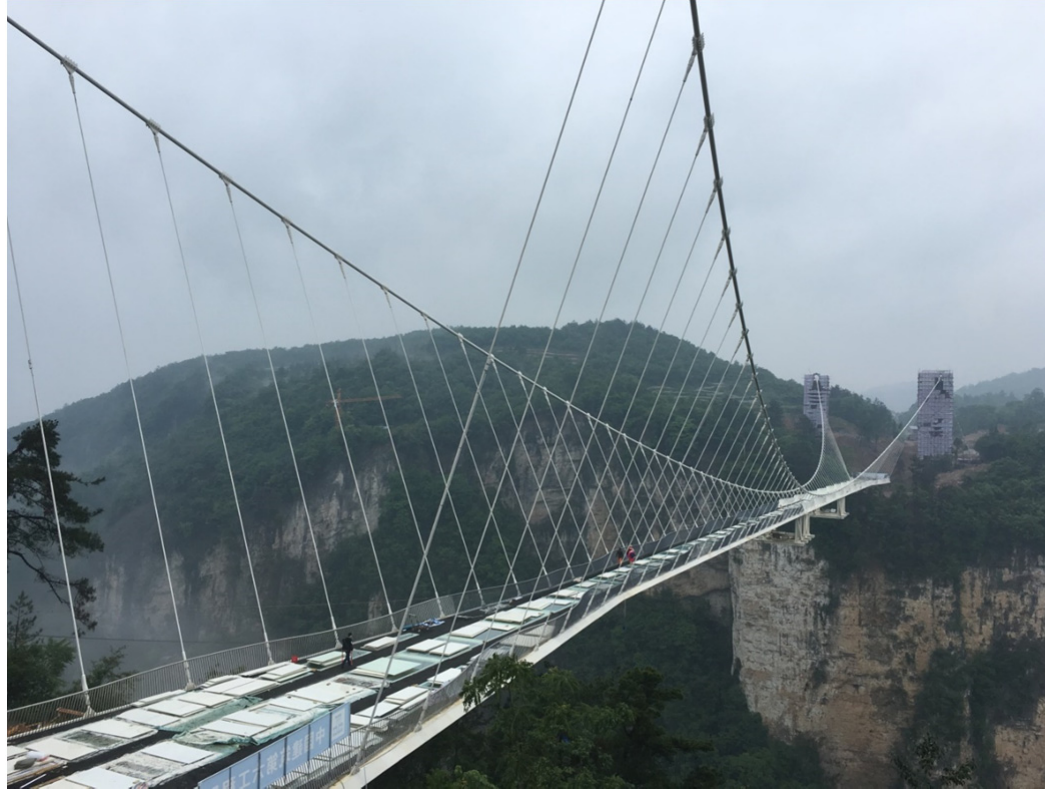
Fig. 9 Zhangjiajie bridge under construction, side view.